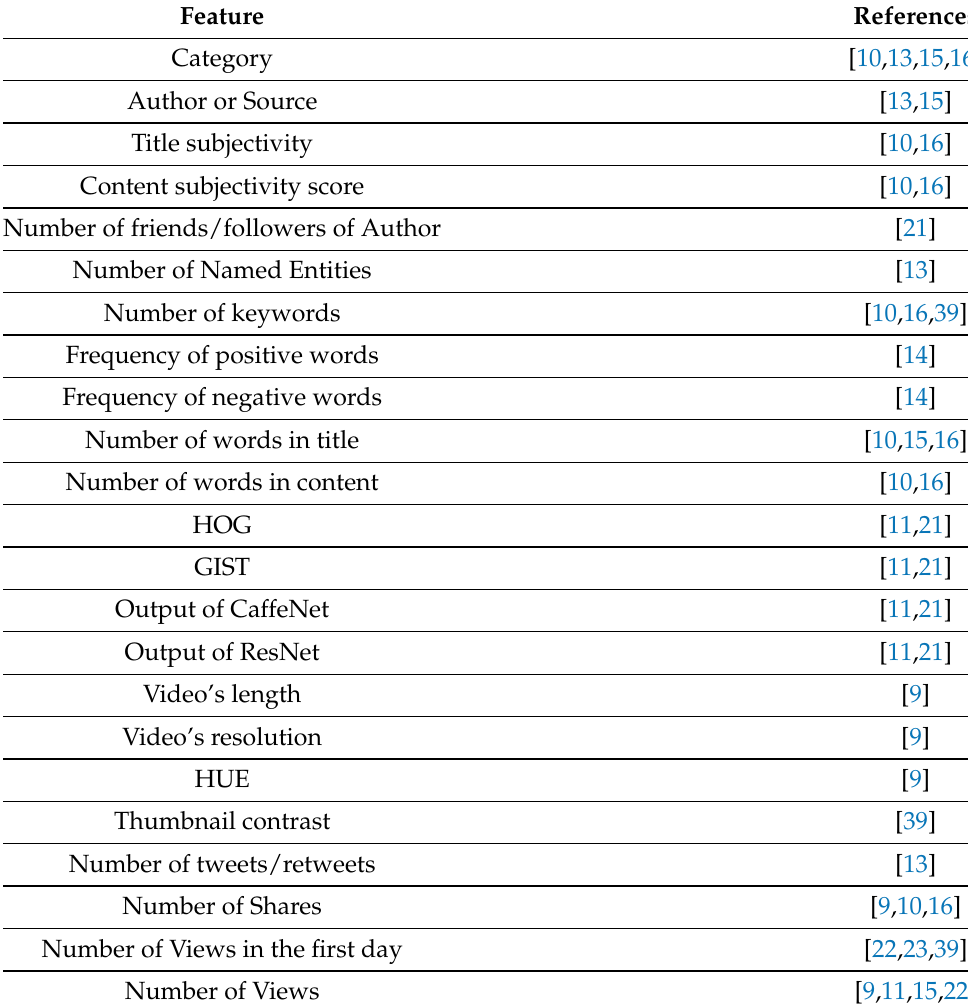
Table 3. Features observed in